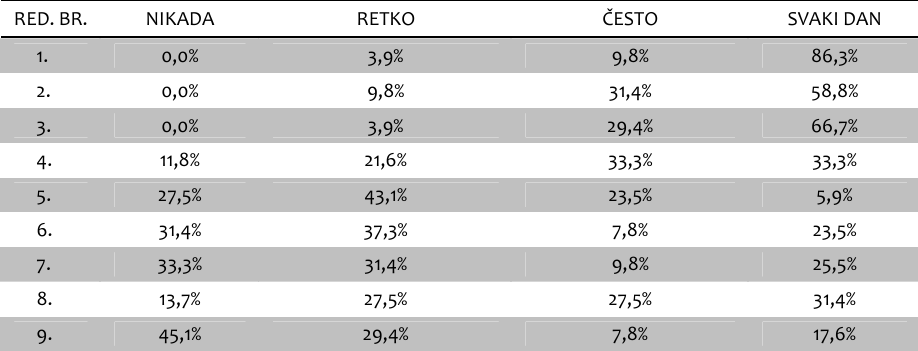
Tabela 2. Stepen i svrha korišćenja interneta od strane srednjoškolaca RED.